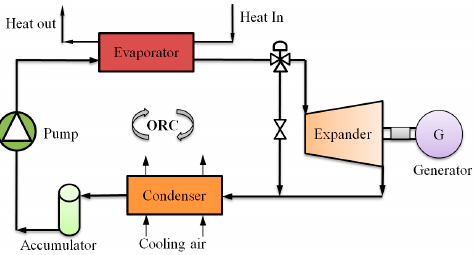
Figure 2. Components of a typical organic Rankine cycle-based waste heat recovery (ORC-WHR) system.